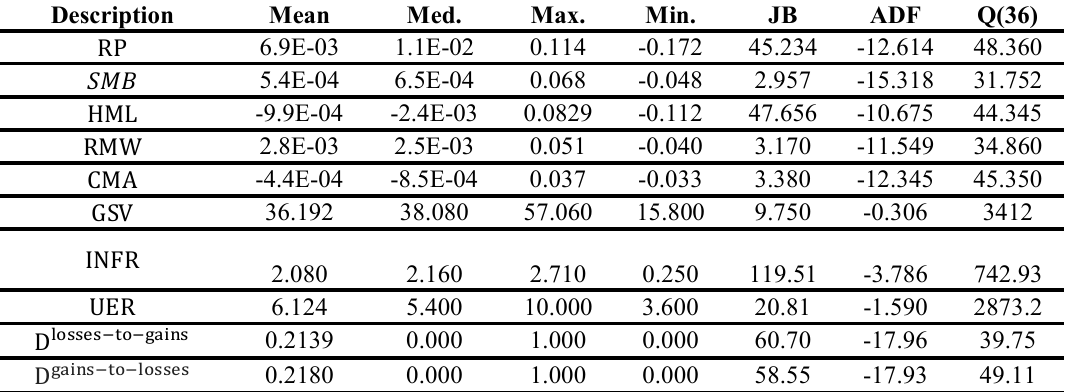
Table.2. Descriptive Statistics of Sample